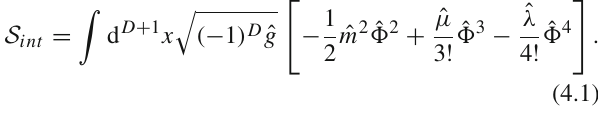
Fig.6. The non-relativistic limit of the tree-level